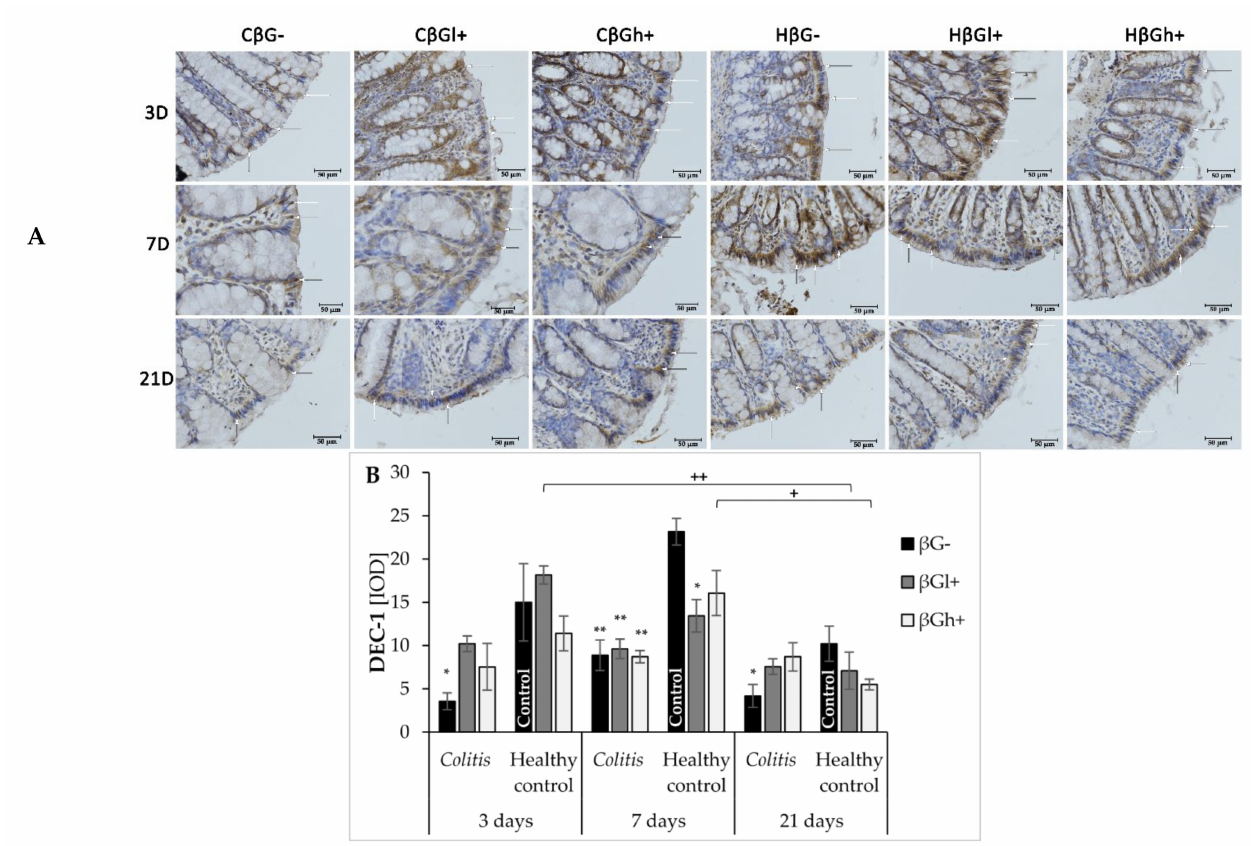
Figure 3. Dectin-1 (DEC-1) expression in colonocytes: results of the immunohistochemical analysis. White arrows indicate colonocytes with high expression of the Dectin-1 (brown precipitate). ( A )—Light micrographs imaged under the NIKON Eclipse Ti2 microscope ( × 40 magnification). Dectin-1 antigen is represented by a brown precipitate in the colonocytes. ( B )— Changes in the expression of DEC-1 in colonocytes presented (mean ± SE) as integrated optical density (IOD). * Significantly different from the control group (healthy control β G − ) at the same time point according to the Dunnett post hoc test (* p < 0.05, ** p < 0.01). + Significantly different from the same subgroups at another time point according to the Tukey post hoc test ( + p < 0.05, ++ p <